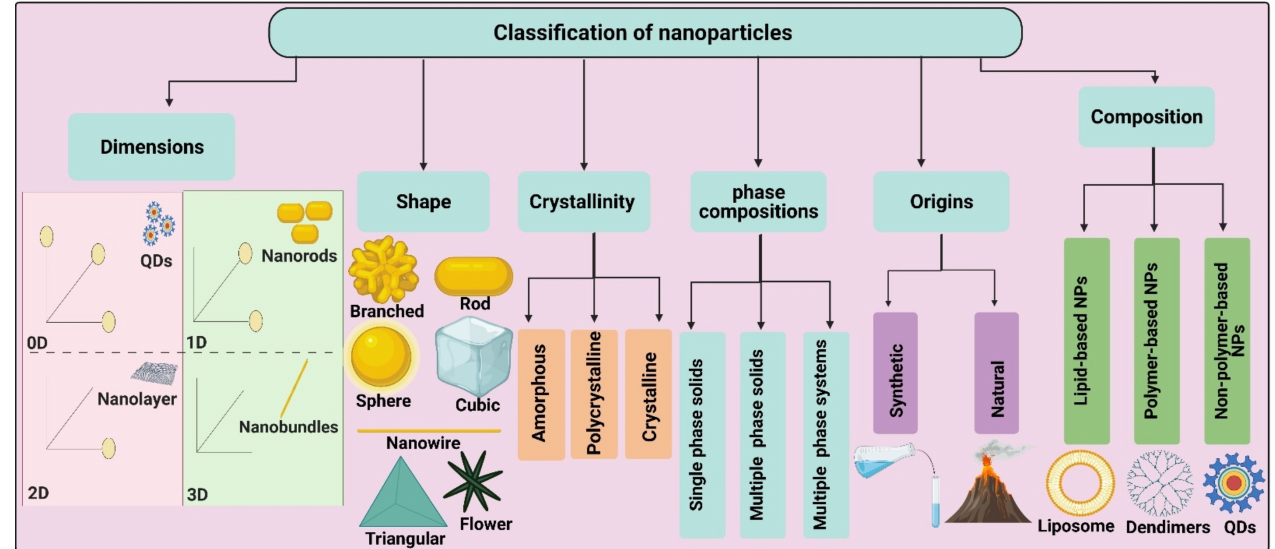
Figure 1. Classifications of nanoparticles